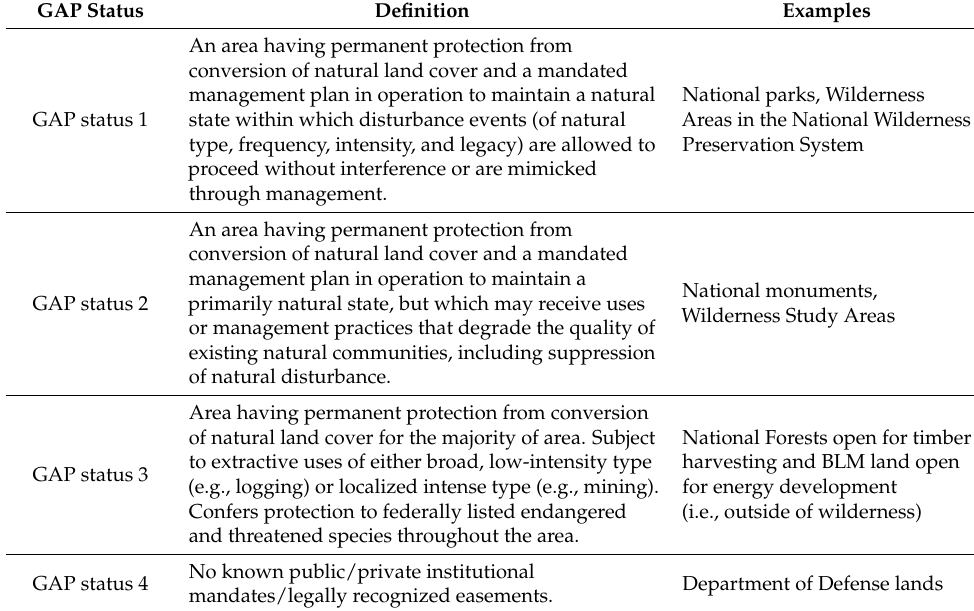
Table 1. Gap Analysis Program (GAP) status classification and overview of conservation protection. WSAs set for release in proposed legislation would functionally demote those areas from GAP 2 to GAP 3. BLM: Bureau of Land